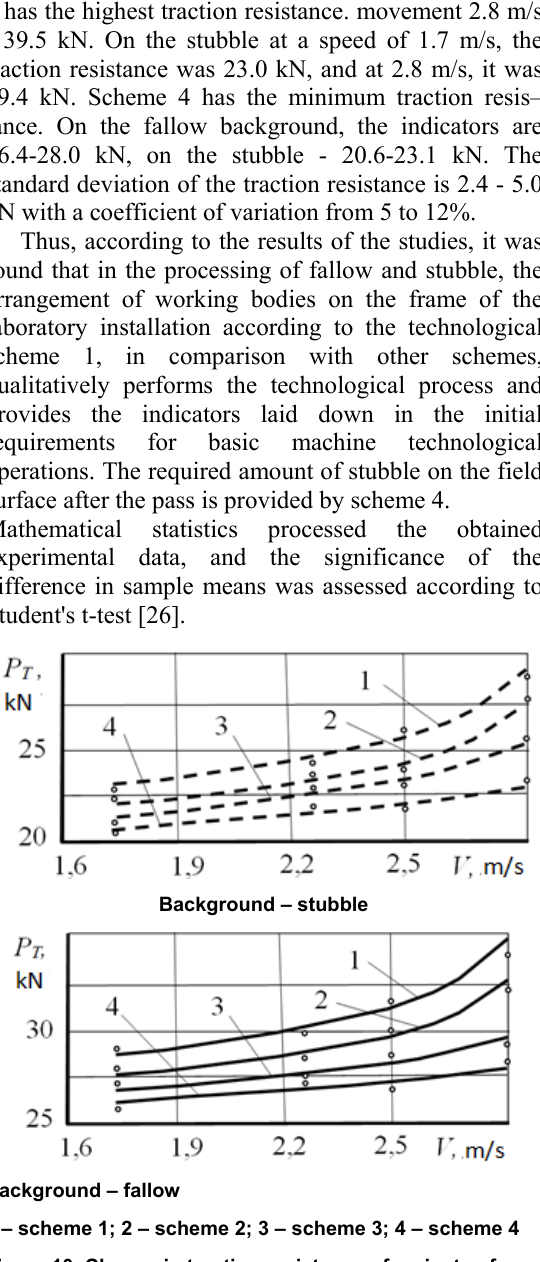
Figure 10. Change in traction resistance of variants of technological schemes depending on the speed of the unit The main factors affecting the unit's productivity include the width of the tool, its traction resistance and speed, and the direct operating costs are the unit's productivity, specific fuel consumption, the price of the tractor, tools, fuels, and lubricants. Only with